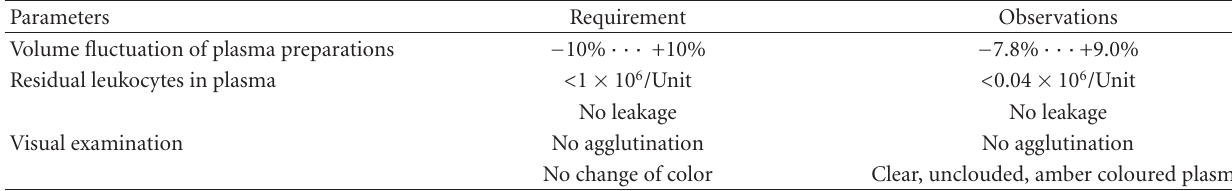
Table 7: Requirements for plasma preparations.